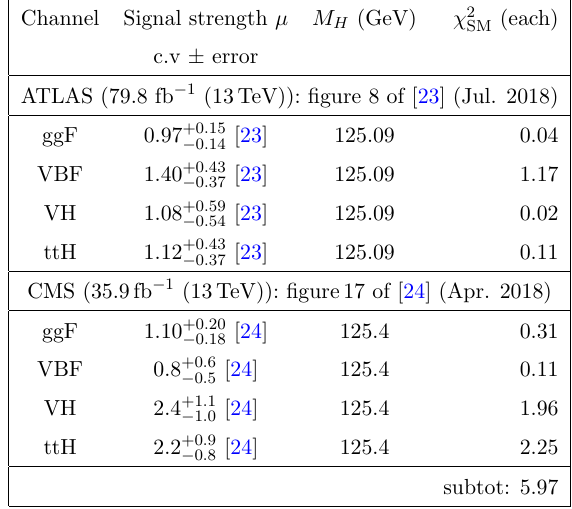
Table 9 . (LHC: 13 TeV) Data on signal strengths of H ! (cid:13)(cid:13) by the ATLAS and CMS after ICHEP 2018. The (cid:31) 2 of each data with respect to the SM is shown in the last column. The sub-total (cid:31) 2 of this decay mode is shown at the end.